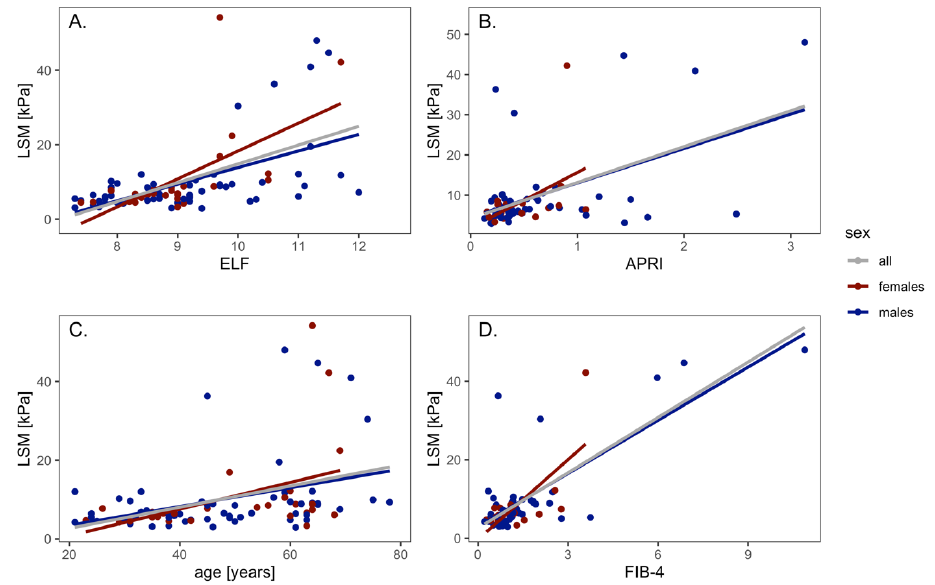
Figure 1. Correlation of LSM with ELF test ( A ), APRI ( B ), age ( C ) and FIB-4 ( D ). The ELF test values correlated with the APRI score (r 2 = 0.14, p = 0.001). The values were in correlation for males (r 2 = 0.12, p = 0.01) as well as for females (r 2 = 0.18, p = 0.04). The ELF test values correlated with age (r 2 = 0.38, p < 0.0001). The values were in correlation for males (r 2 = 0.37, p < 0.0001) and for females (r 2 = 0.38, p = 0.0001). The ELF test values correlated with the FIB-4 (r 2 = 0.34, p < 0.0001); the values were in correlation for males (r 2 = 0.32, p < 0.0001) and for females (r 2 = 0.50, p = 0.006) (Figure 2).